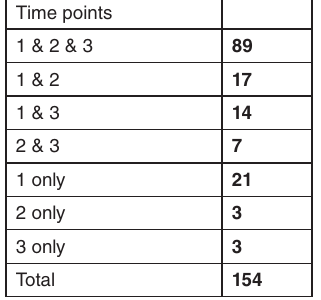
Table 4: Number of students completing the inventory at different time